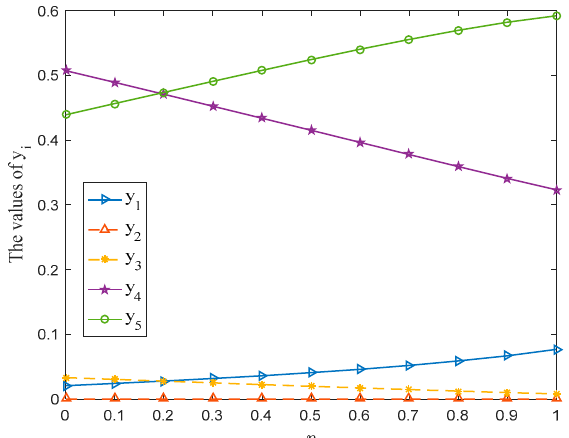
Figure 5. y i with parameter η varying from 0 to 1.